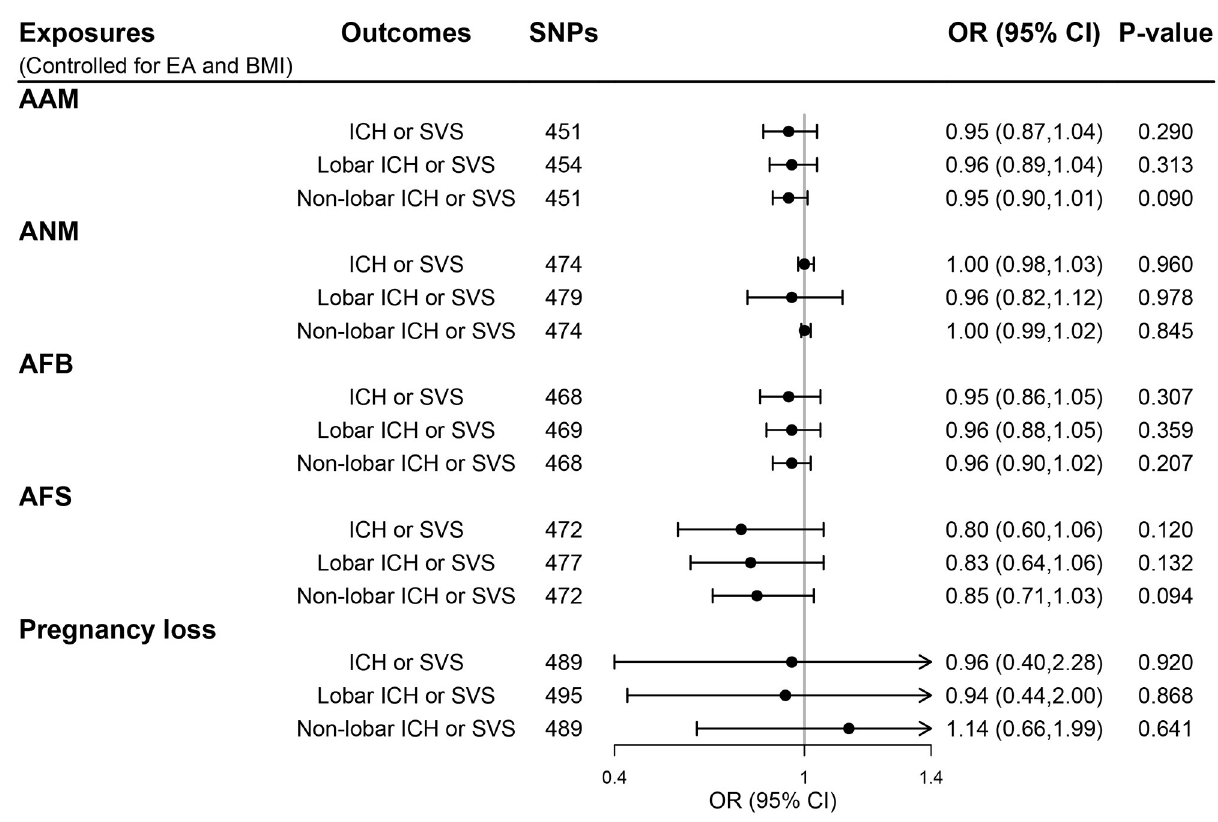
FIGURE4 The direct effect of genetically determined women’s reproductive traits on CSVD clinical outcomes using MVMR controlled for EA and BMI. AAM, age at menarche; AFB, age at first birth; AFS, age at first sexual intercourse; ANM, age at natural menopause; BMI, body mass index; EA, educational attainment; ICH, intracerebral hemorrhage; SVS, small-vessel ischemic